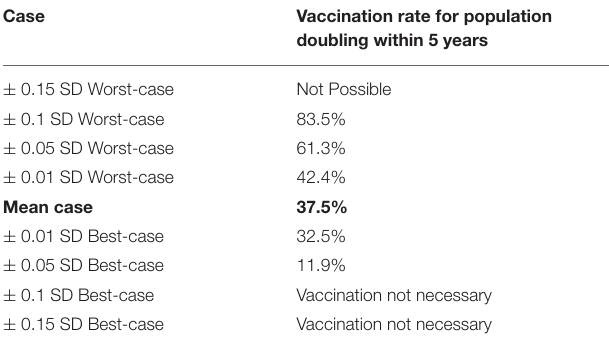
TABLE 4 | The vaccination rate needed for population doubling in 5 years is calculated for parameter values assuming different values with respect to their standard